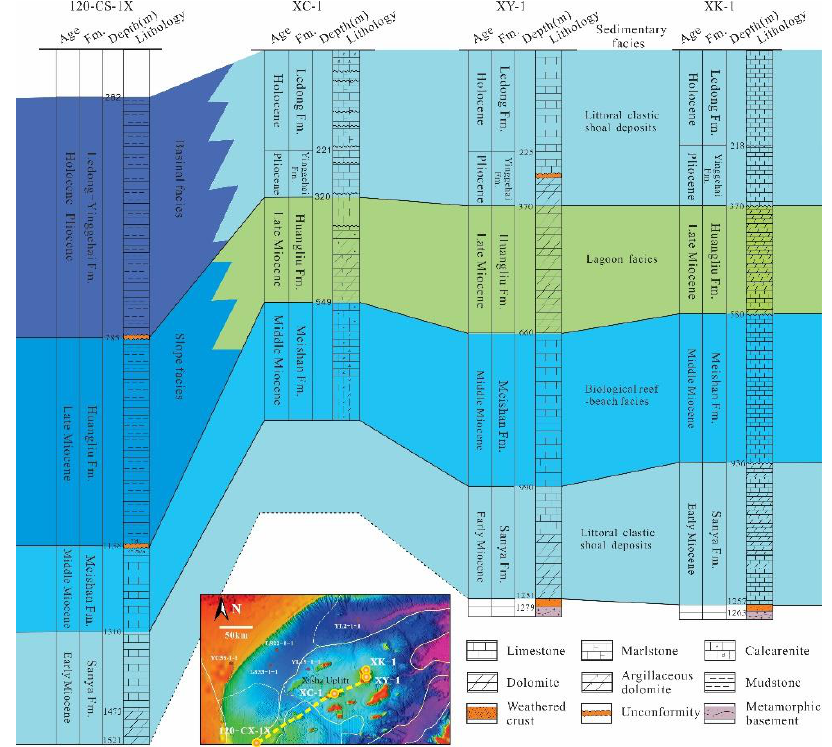
Figure 4. The cross-section of wells from Well 120-CS-1X to Well XK-1 for sedimentary facies and lithological combinations from the Early Miocene to the Holocene on the uplifts at the Xisha sea area. The well locations are shown at the bottom of the scaled map in Figure 1B.